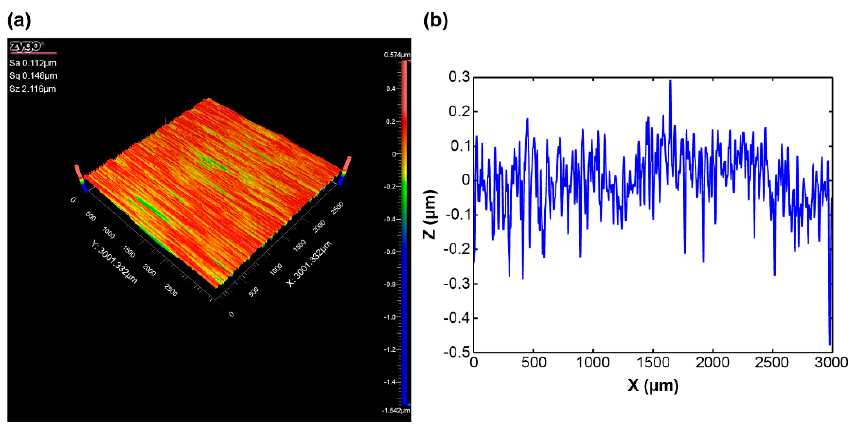
Figure 1. ( a ) Three-dimensional image of a 304 stainless-steel grinding surface at 𝑆𝑎 0.122 μ m. ( b ) Vertical section image of a 304 stainless-steel grinding surface at 𝑆𝑎 0.122 μ m.